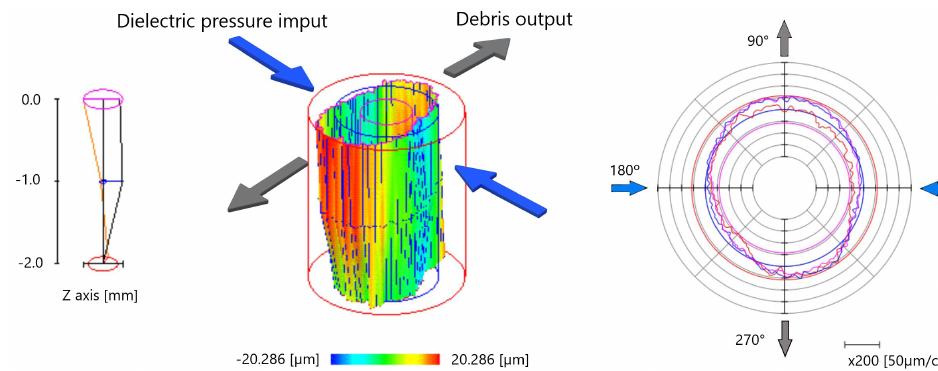
= 37 A, t = 180 µs). e e